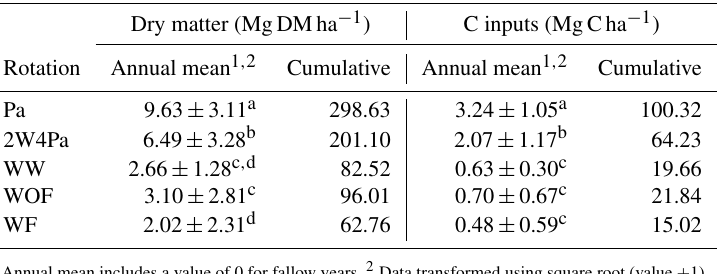
Table 1. Mean and standard deviation of annual treatment production and soil C input data during 1963–1993. Significant differences (one-way ANOVA, α< 0 . 05) between rotations are indicated with different letters in each column.